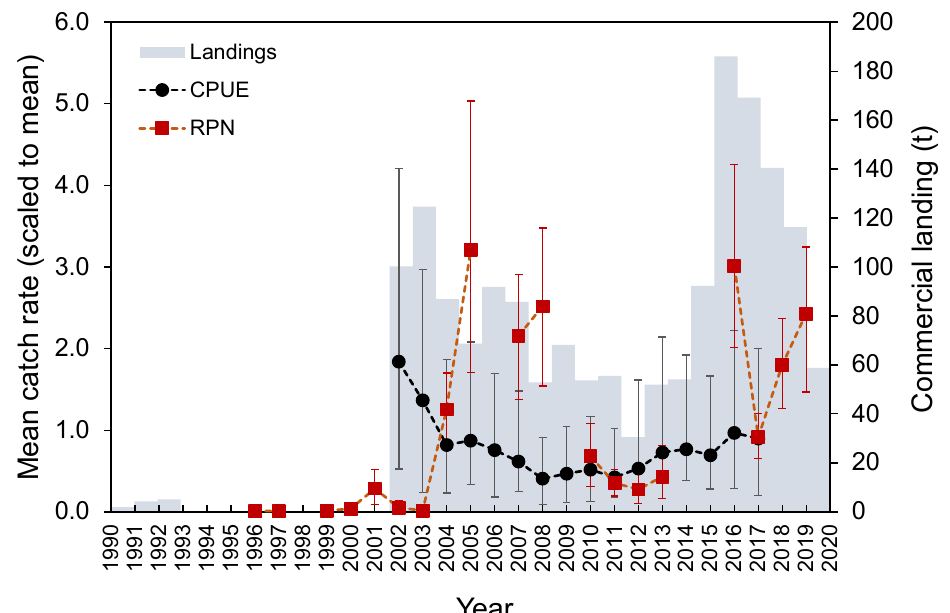
Figure 9. Official total landings (tons), mean ( ± 0.95 confidence interval) CPUE (kg days at sea − 1 vessel − 1 ) from the commercial fishery and RPN (ind. 10 − 3 hooks) derived from the surveys catch rates of Mora moro in the Azores.